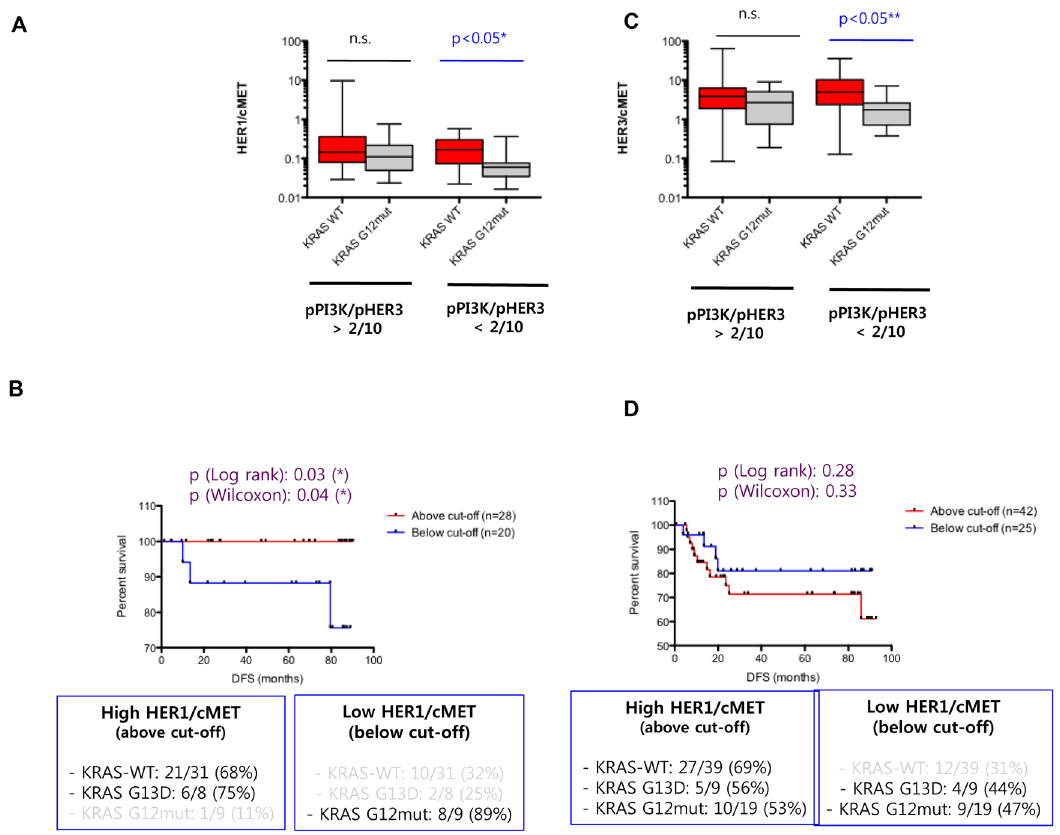
Figure 4. Summary of colorectal cancer (CRC) sub-classifications based on their signaling pathway profiles. Schematic summarizing the sub-classification of CRCs based on their signaling pathway profiles and KRAS mutational status. The possible therapeutic options for each sub- class based on their pathway profiles are indicated.